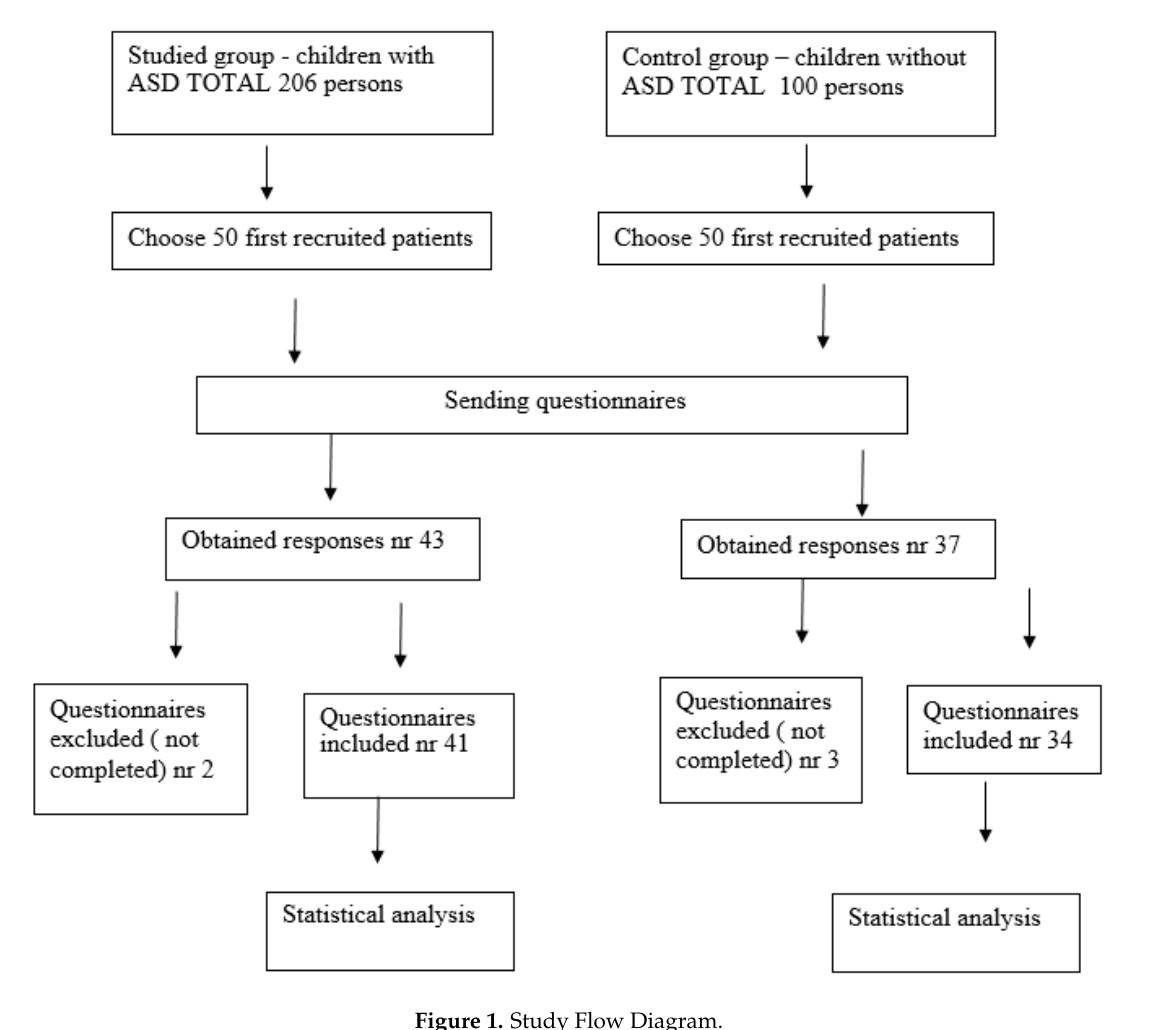
Figure 1. Study Flow Diagram.